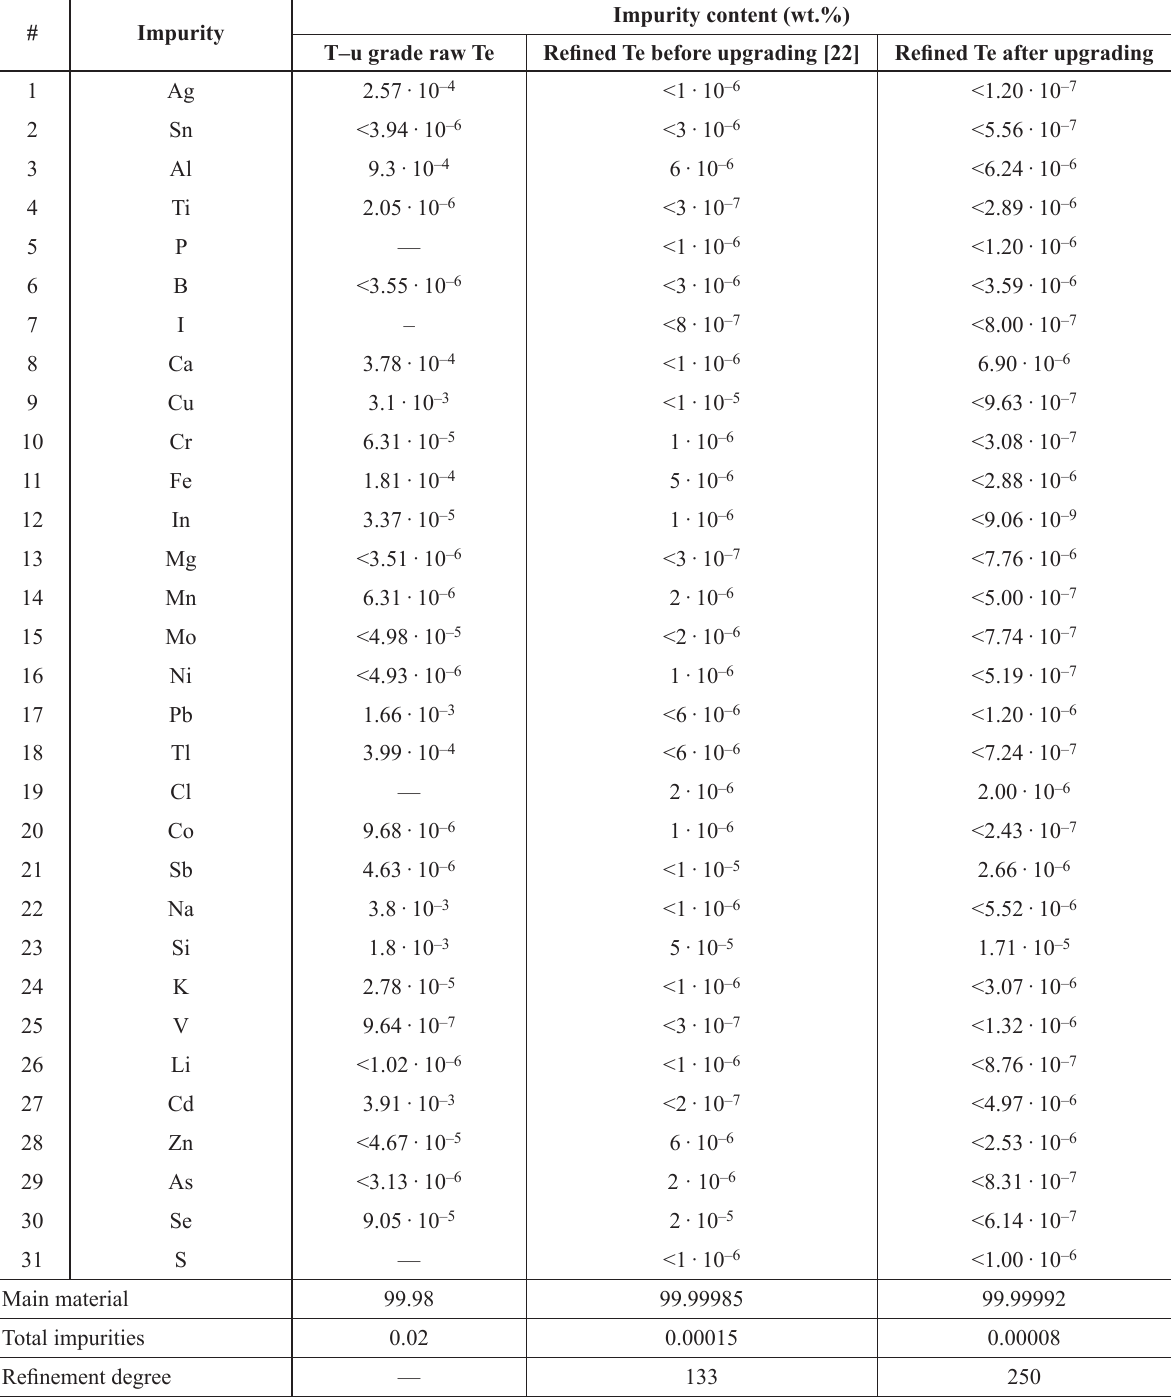
Table 4. Elemental composition of Te samples taken at the initial, interim and final process